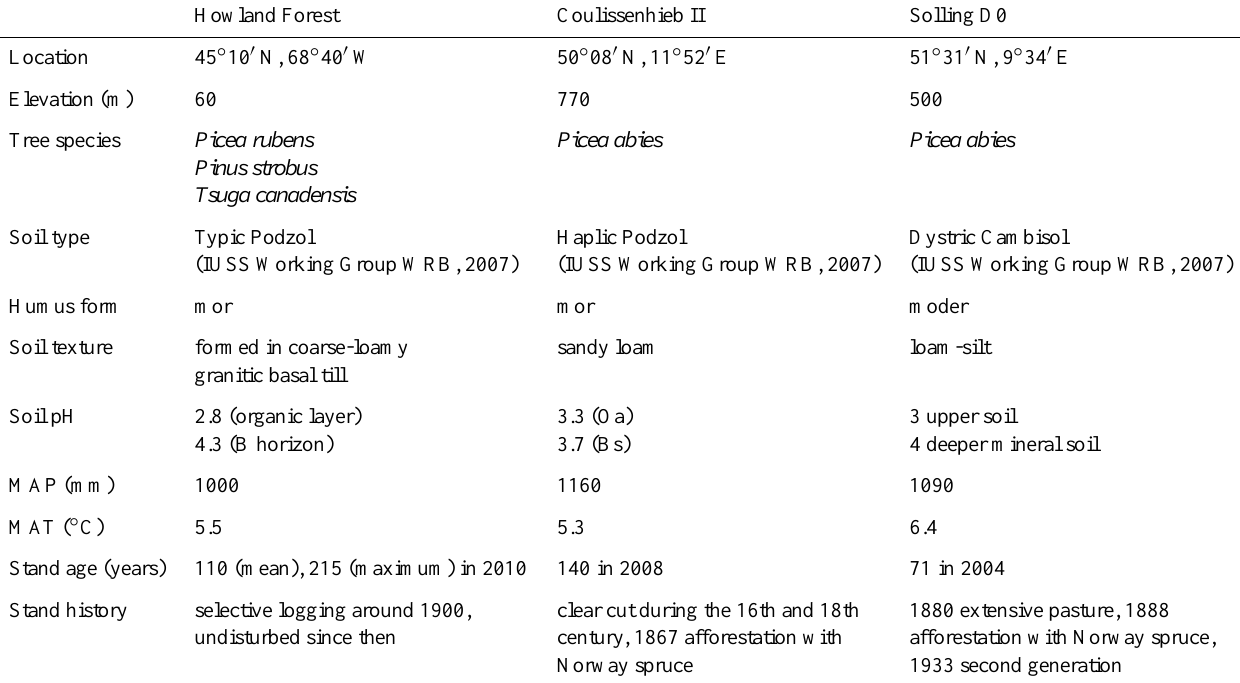
Table 1. Location, elevation, dominant tree species, soil type according to IUSS Working Group WRB, humus form, soil texture, soil pH(CaCl 2 ), mean annual precipitation (MAP), mean annual air temperature (MAT), stand age, and site history of the 3 study